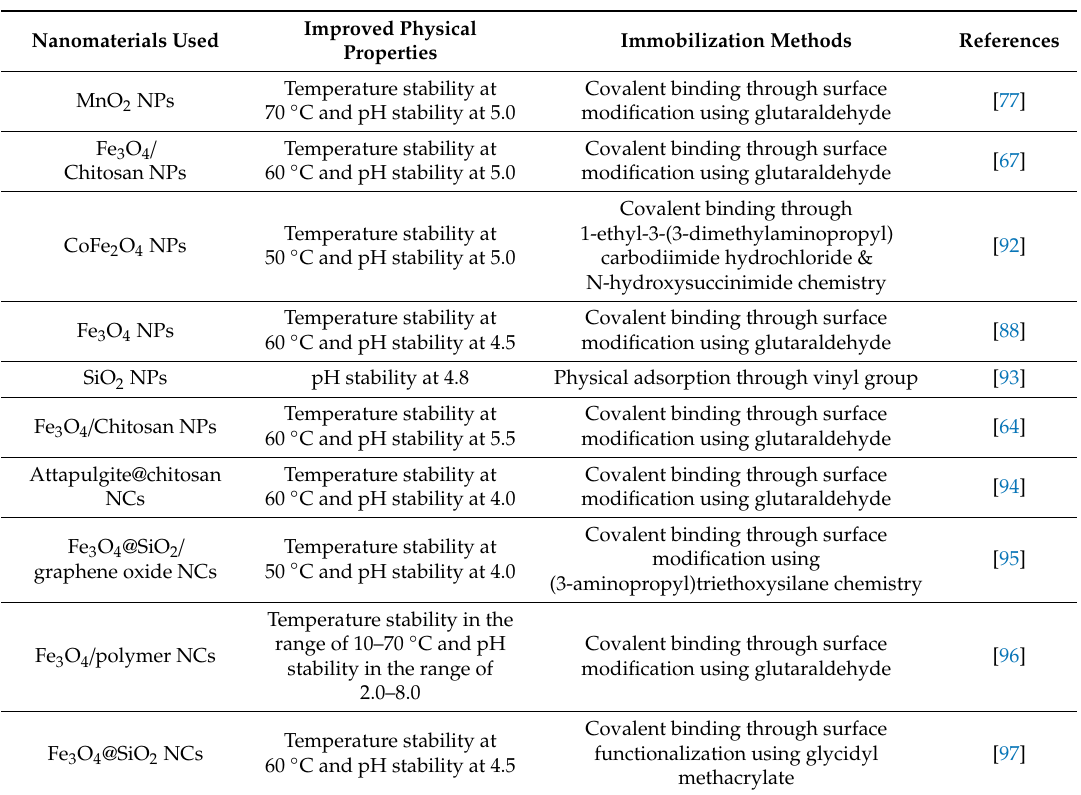
Table 2. Improvement of pH and temperature stability using immobilized cellulases on di ff erent types of